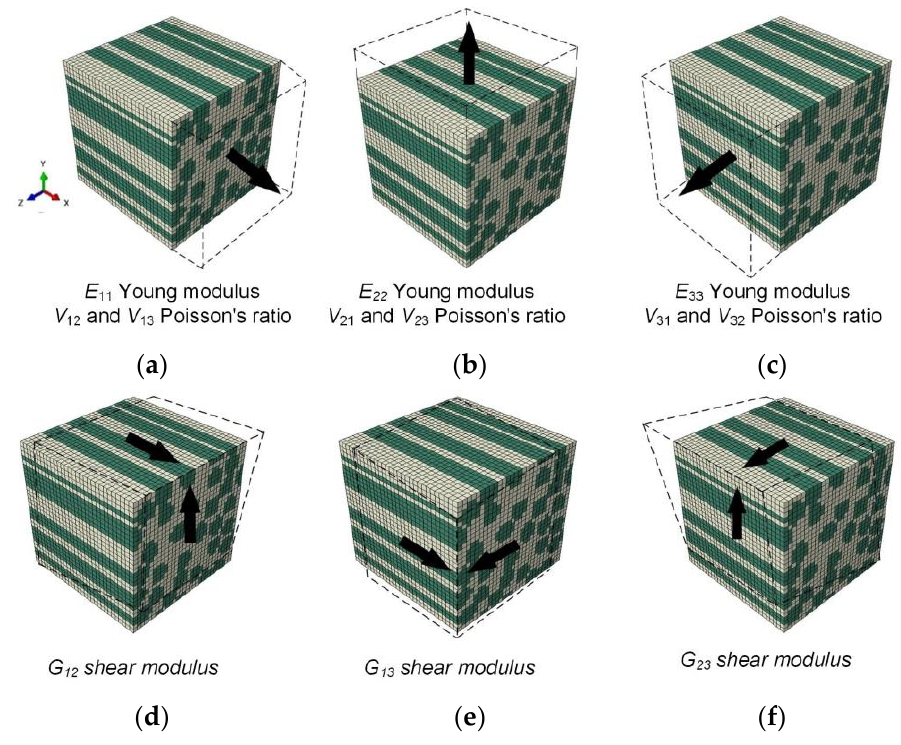
Figure 4. Boundary conditions of the calculations of equivalent elastic constants.